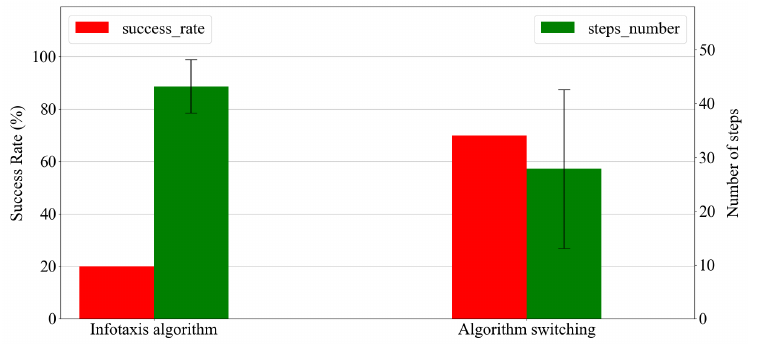
Figure 17. Success rate and search time for the two